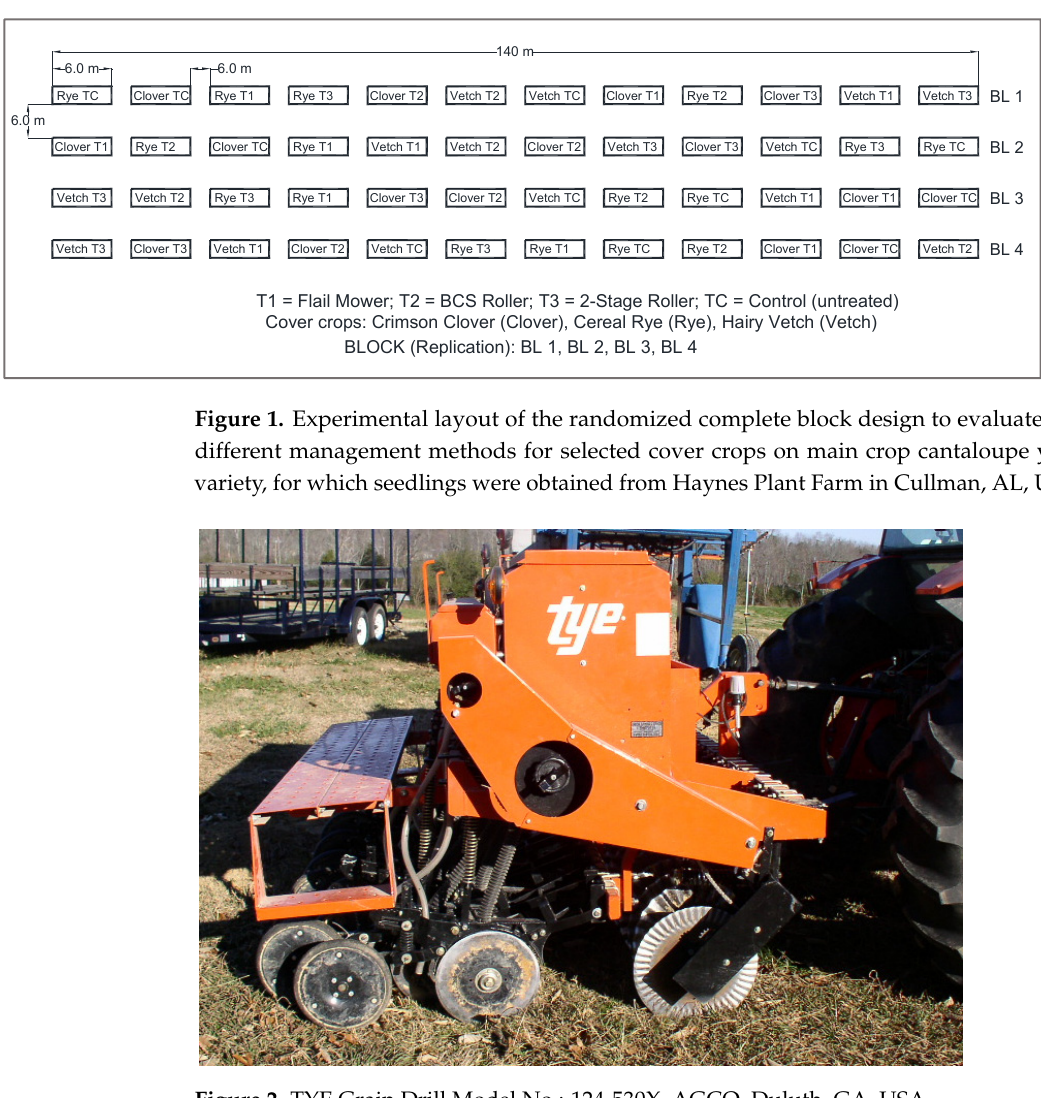
Figure 2. TYE Grain Drill Model No.: 124-530X, AGCO, Duluth, GA, USA.